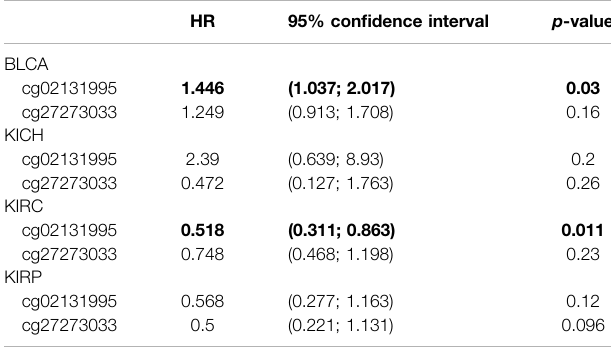
TABLE 3 | Prognostic value of DNA methylation of hepcidin in patients with male genitourinary system